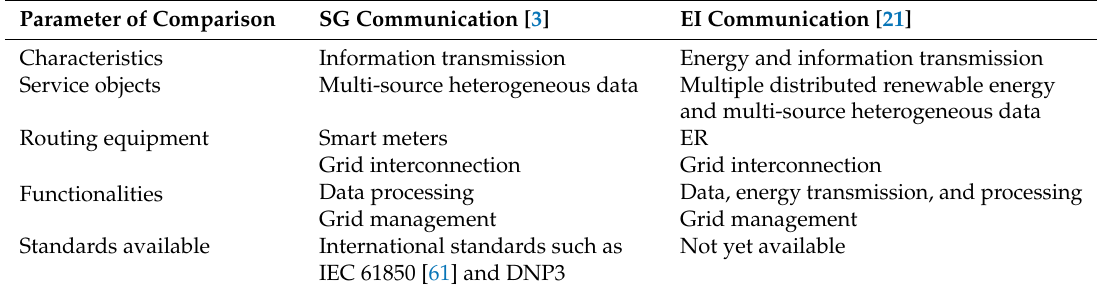
Table 2. Comparative features between the smart grid and energy